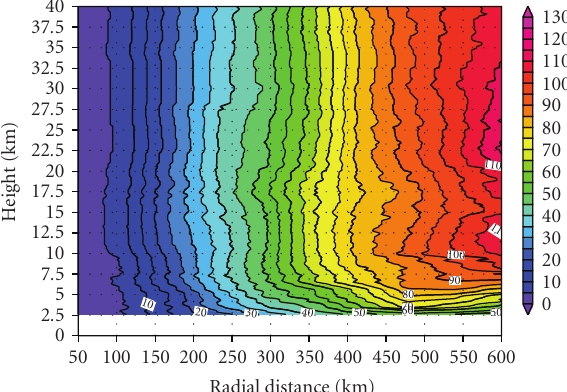
Figure 3: Radial cross-section of GPS RO counts for all TCs in di ff erent 50 km radial distance bands. Contour interval is 5